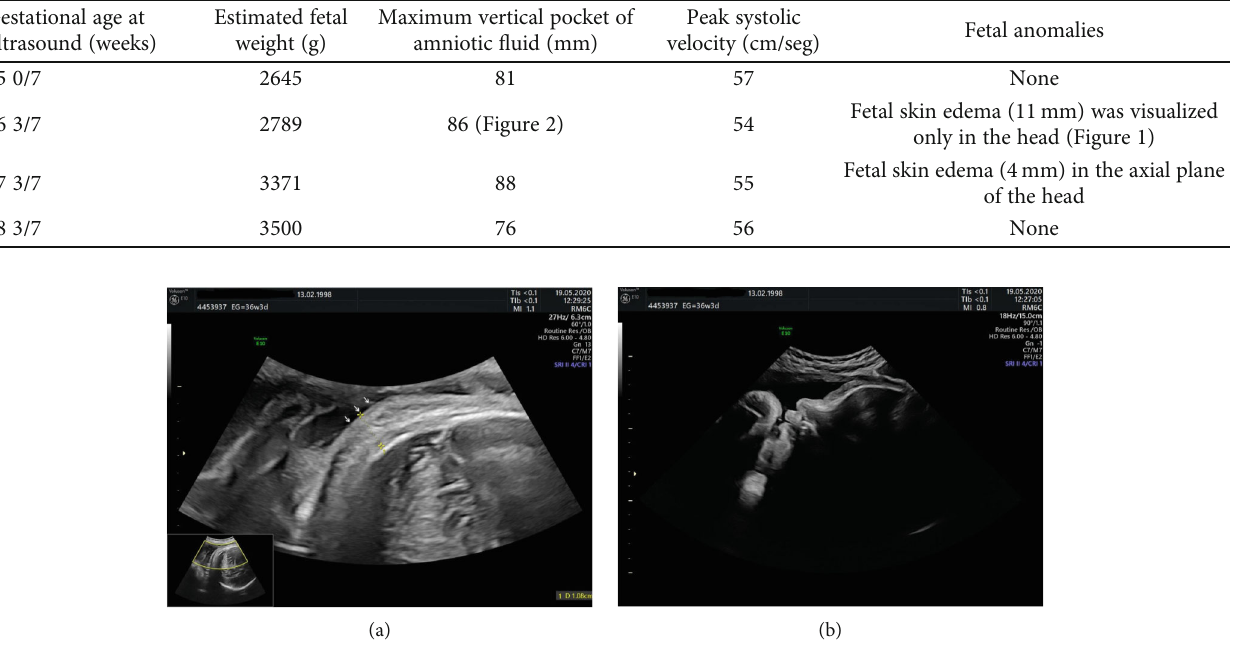
Figure 1: (a) A transitory fetal skin edema (11 mm) was visualized in the axial plane of the fetal head by ultrasound at 36 3/7 weeks of pregnancy. (b) Sagittal view of the transitory fetal head skin edema at 36 3/7 weeks of pregnancy.